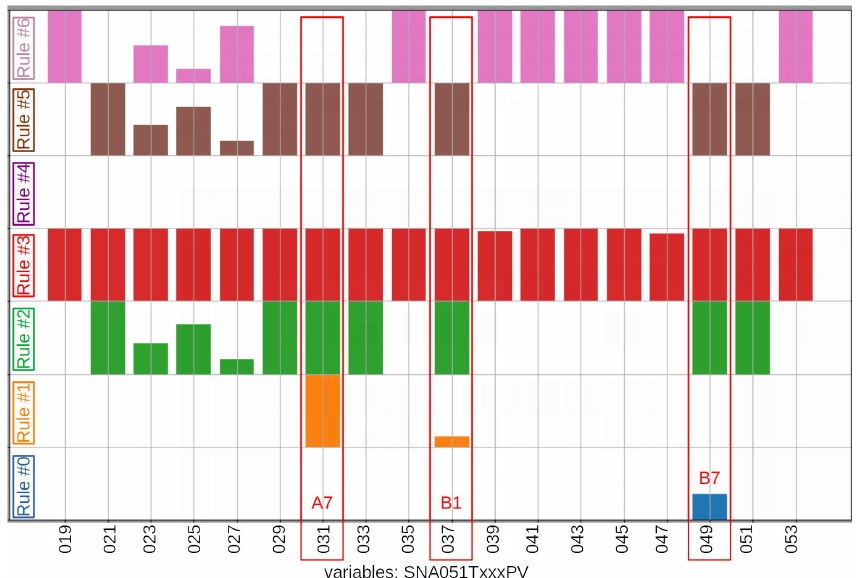
Figure 12. Bar graph of the exhaust gases subsystem during time window #2 (between 13:51 and 14:39).